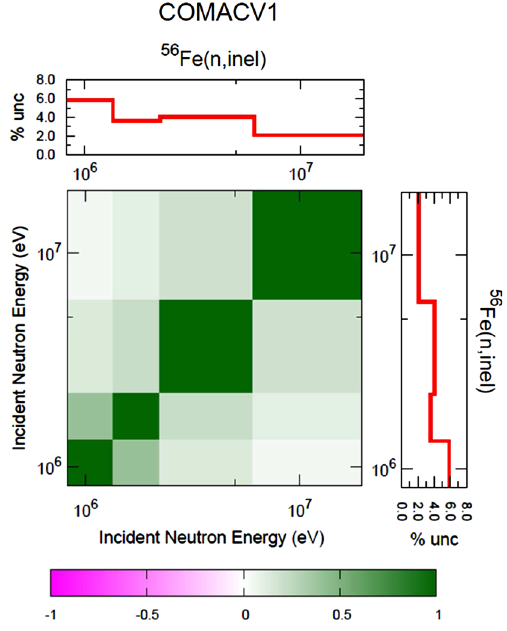
Fig. 8. 56 Fe inelastic uncertainty and energy correlation: